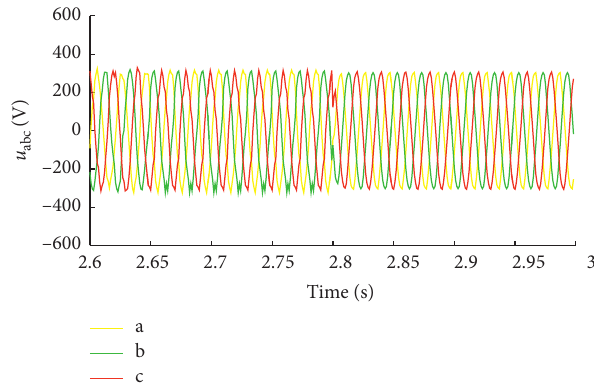
Figure 9: Voltage waveforms of the ESS (output power increases from 10kW to 40kW).